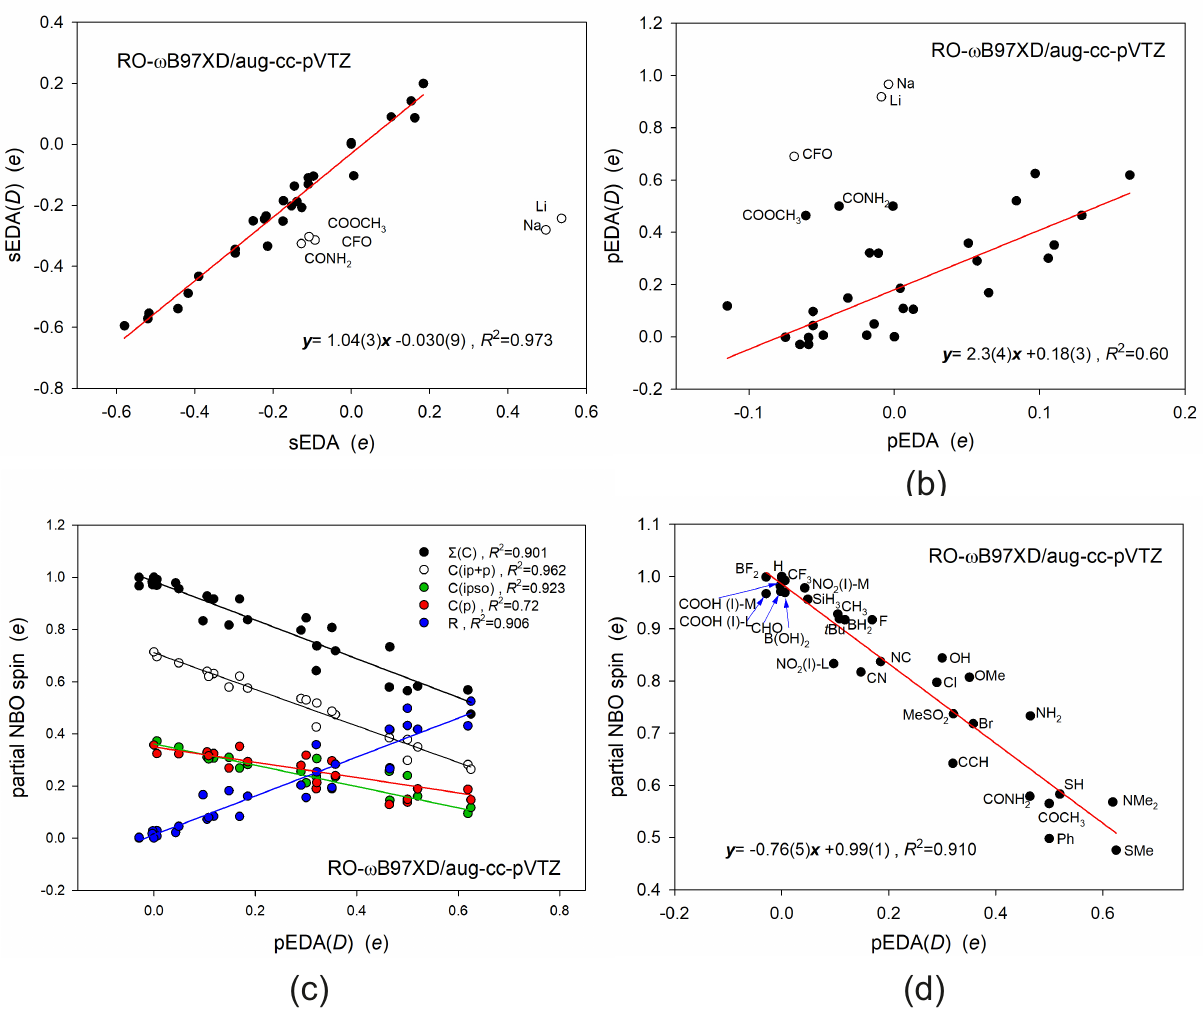
Figure 6. Linear regressions between the ground state sEDA ( a ) and pEDA ( b ) substituent effect descriptors and the reciprocal descriptors for the cation radicals. ( c ) Linear correlations between the pEDA(D) descriptor and spin densities at the sum of the ring C atoms ( Σ C), and C(ipso), C(p), C(ipso+p) atoms, as well as at the substituent R, and ( d ) the correlation between the pEDA(D) descriptor and spin densities at the sum of the ring C atoms ( Σ C) with the substituent type shown. The following regression lines were, respectively, obtained: y = − 0.74(5)x + 0.98(1); y = − 0.70(3)x + 0.71(1); y = − 0.41(3)x + 0.36(1); y = − 0.29(4)x + 0.35(1); y = − 0.75(5)x + 0.01(1). All results were obtained with the RO-DFT method, but analogous relationships also adhere to the U-DFT data. In graphs ( c , d ), all atypical systems (forms (II) and (e)) were